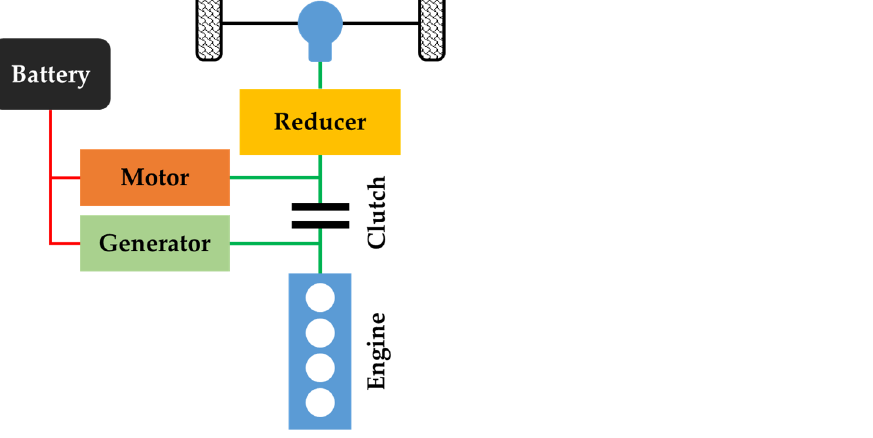
Figure 1. Powertrain layout. Table 1. Powertrain and vehicle specification.